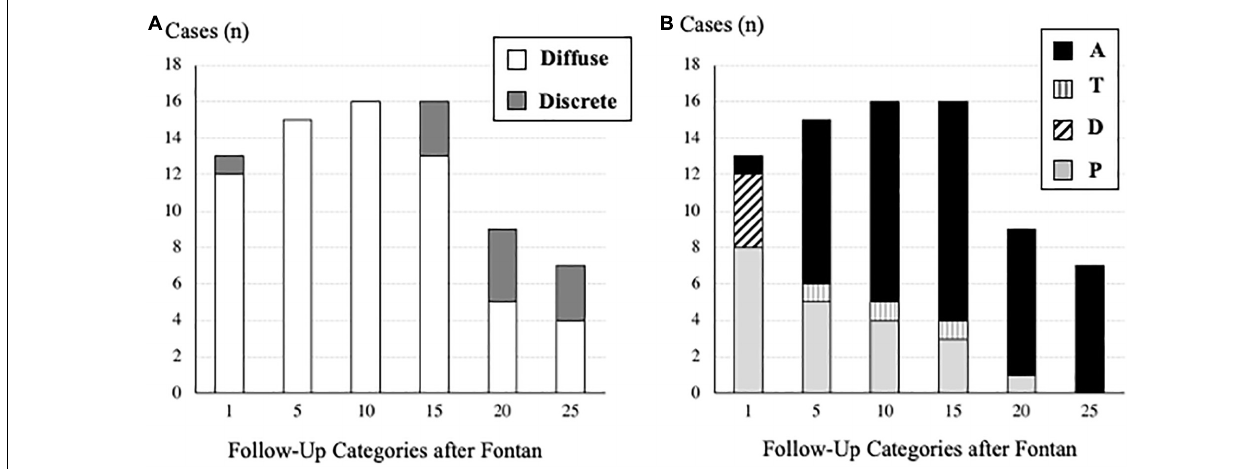
FIGURE 2 | (A) Number of cases of pulmonary arteriovenous fistulae based on the morphology (diffuse or discrete) in each follow-up category after the Fontan operation. (B) Number of cases of pulmonary arteriovenous fistulae based on the time-course (A, T, D, P) in each follow-up category after the Fontan operation. Definition of each type (A, T, D, P) is described in the “Materials and Methods” section.